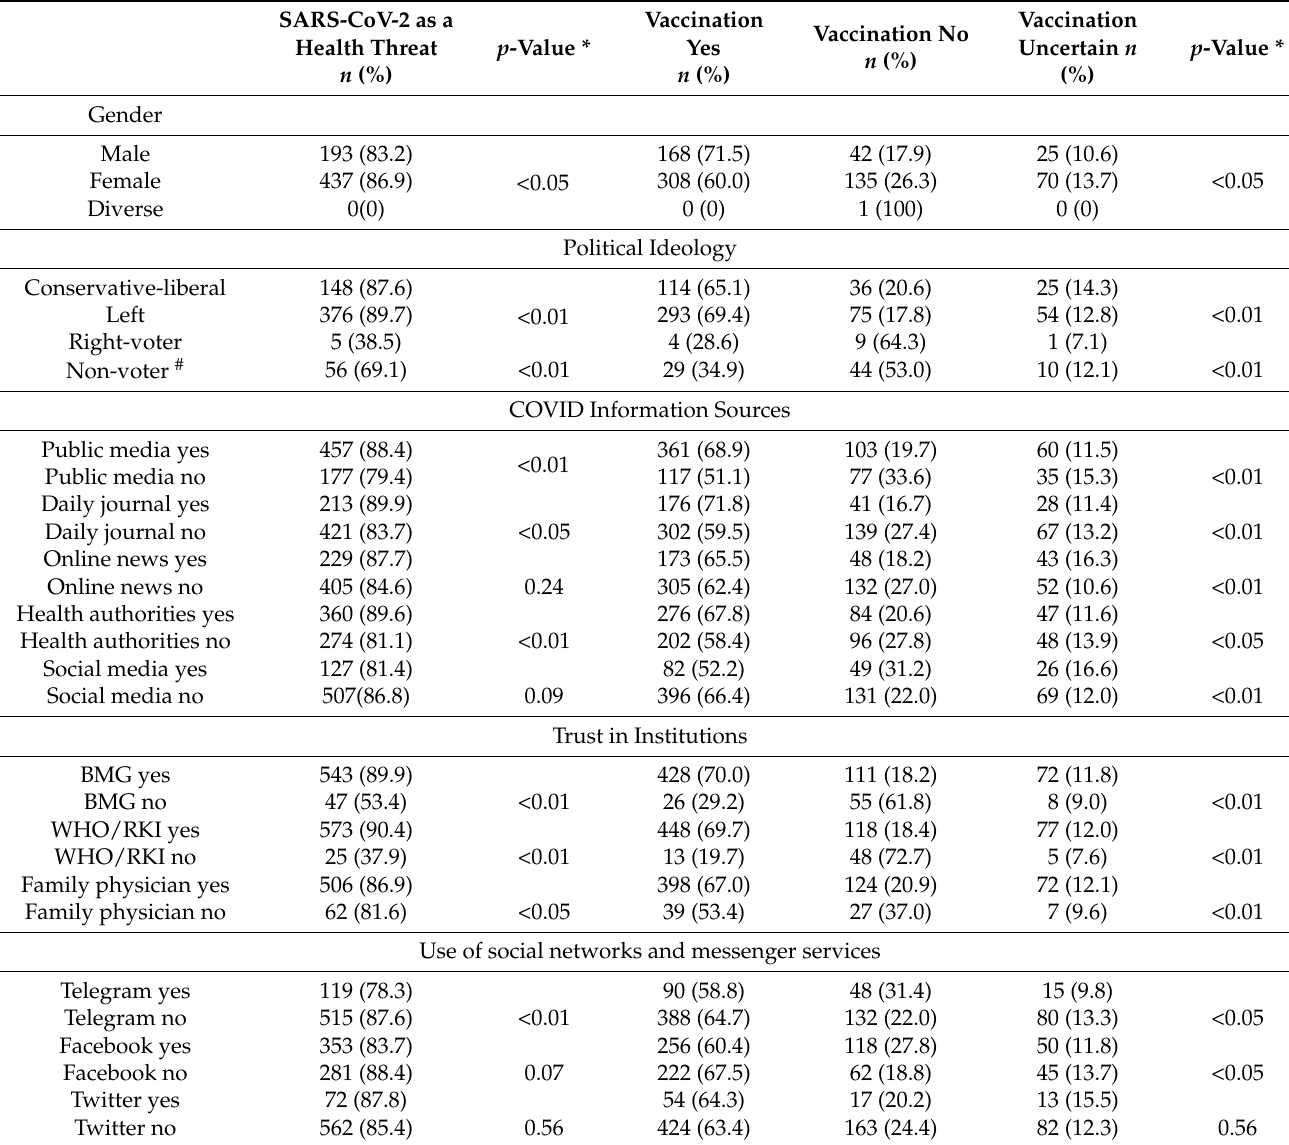
Table 3. Influencing factors on risk perception and vaccination